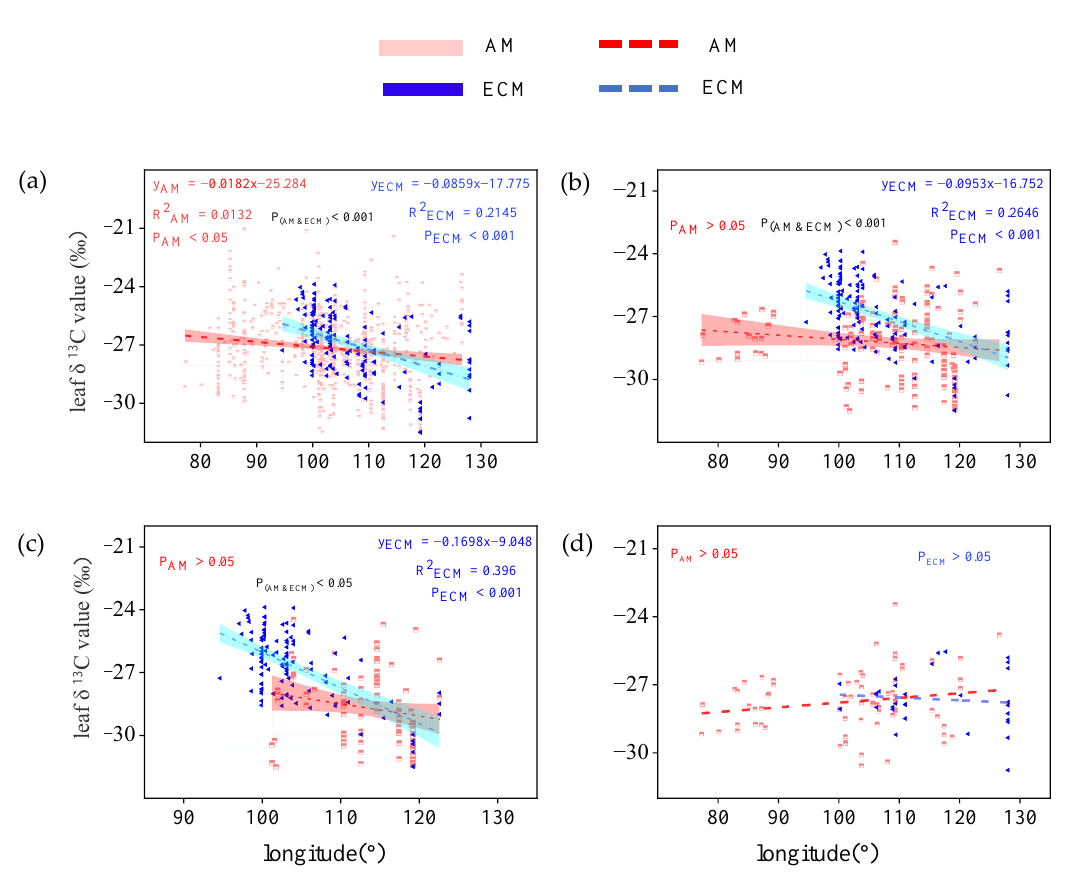
Figure 2. Variation of leaf δ 13 C in AM plants and ECM plants with different life forms along longitude. ( a ) Total plants, include all plants in the database without distinguishing their life forms ( b ) trees, only contain all the tree species in the database ( c ) evergreen trees, only contain all evergreen trees of the tree species ( d ) deciduous trees, only contain all deciduous trees of the tree species. The red broken line means AM, the blue broken line means ECM. The red and cyan bands represent, respectively, the prediction intervals of AM and ECM plants. P(AM and ECM) represents the significant difference in the slope of the two regression lines.